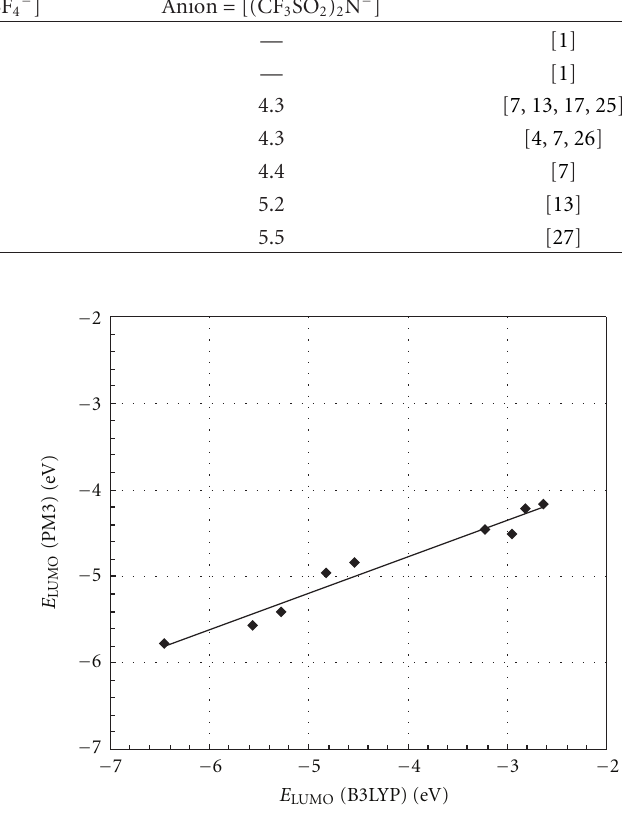
Figure 5: Comparison of calculated E LUMO of several cations by B3LYP and PM3 calculations. The correlation coe ffi cient is